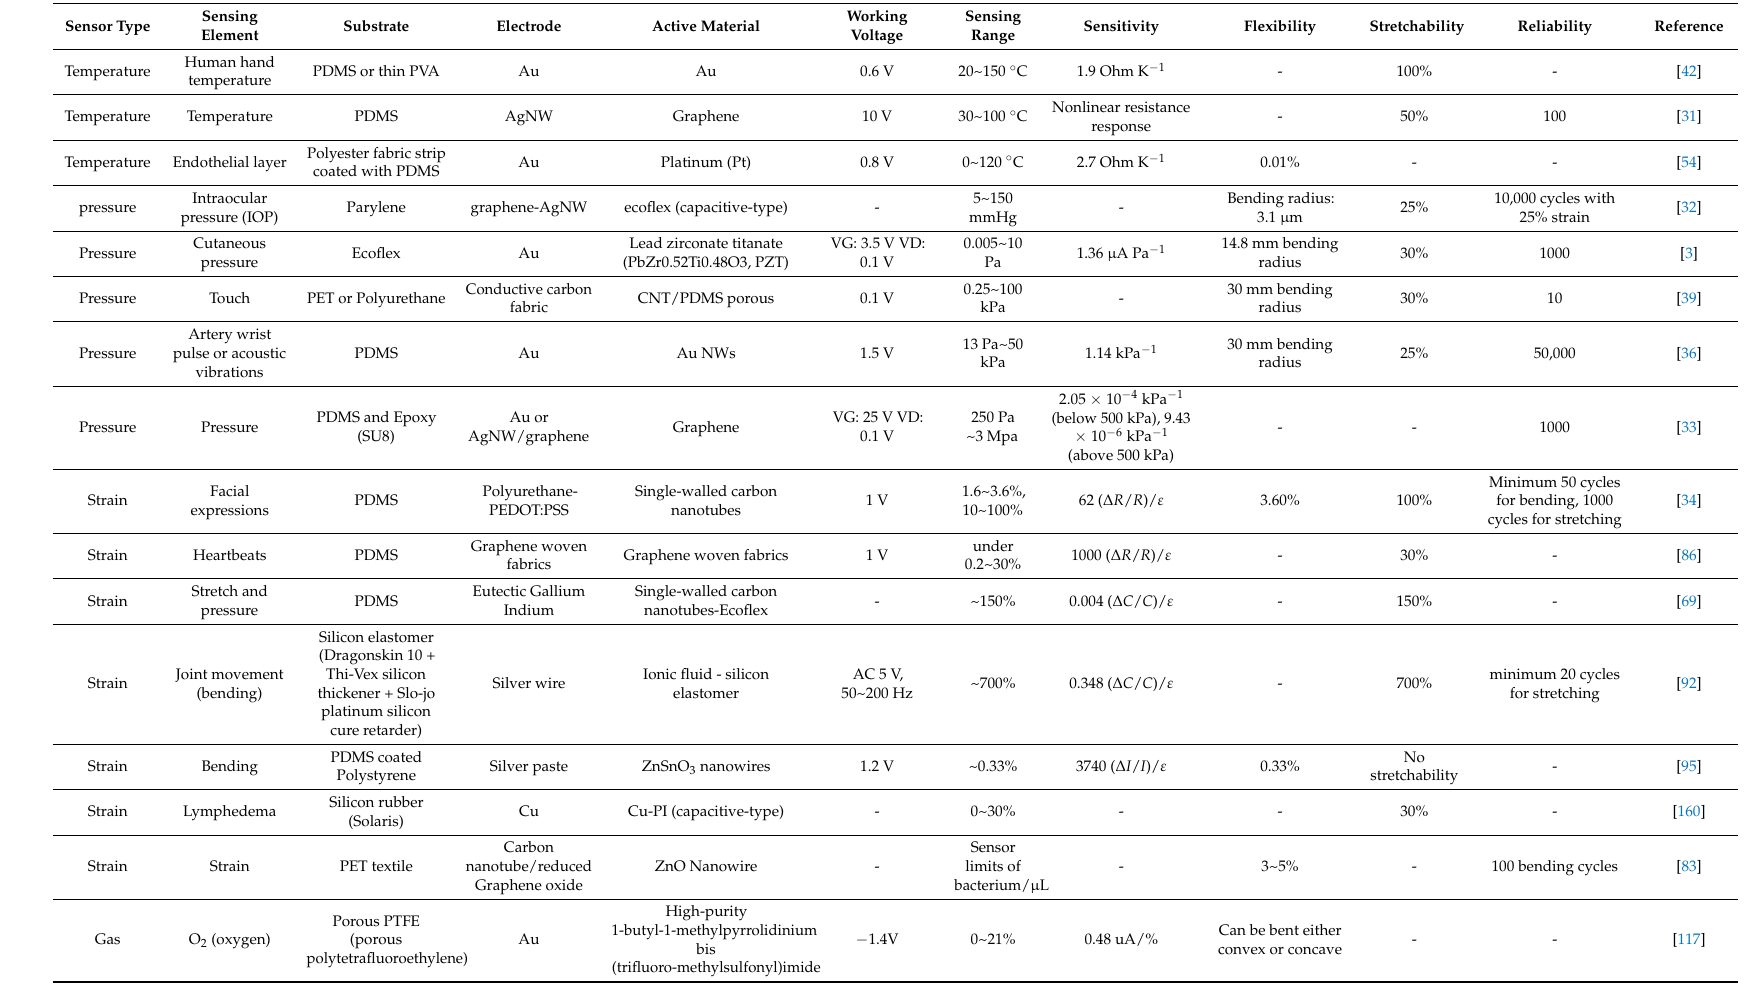
Table 1. Summary of the wearable